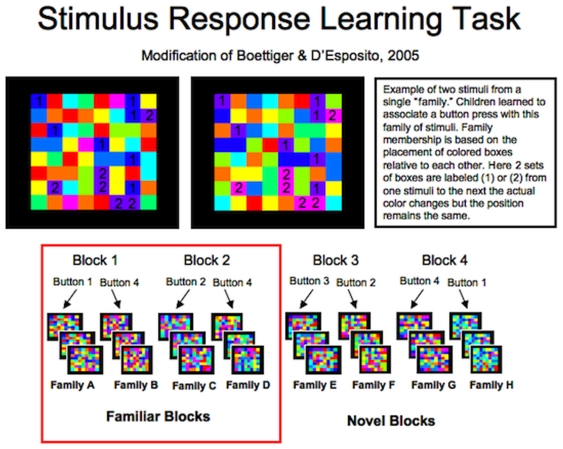
Example of stimuli used in task.(Top) Two stimuli from the same family: although the colors change from one exemplar of a family category to another, the pattern of colors remain the same. In the left exemplar, the “1” blocks are blue, but in the right exemplar, these same blocks are purple. Similarly, the blocks which are purple in the left exemplar are “2” blocks, but these same blocks are pink in the right exemplar. (Bottom) Examples of all the families of stimuli used in this task. During each block, participants were taught to distinguish between 2 families of stimuli. They were taught to press one button when shown exemplars from one family and another button when shown exemplars of the other families. All together 4 possible button presses were used during the course of the task (1, 2, 3, or 4); chance performance was 25%.